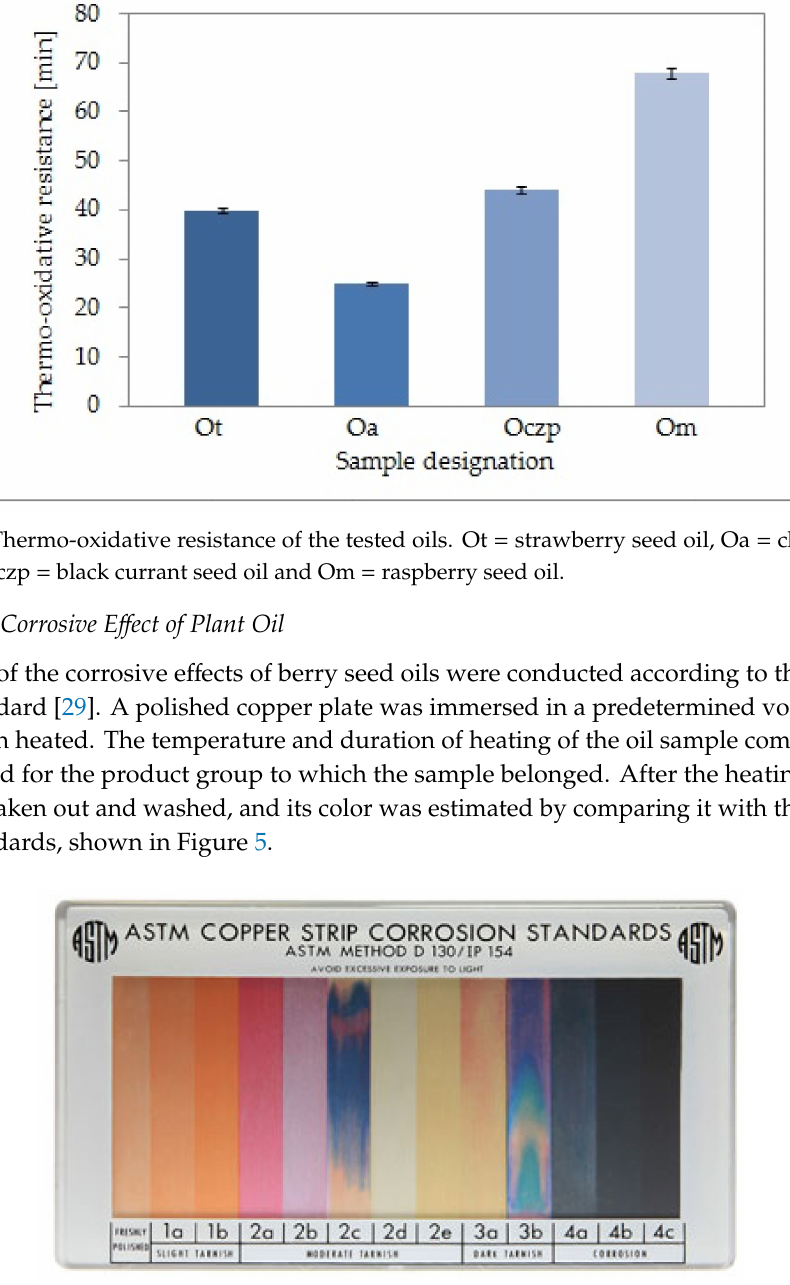
Figure 5. Copper strip corrosion standards.